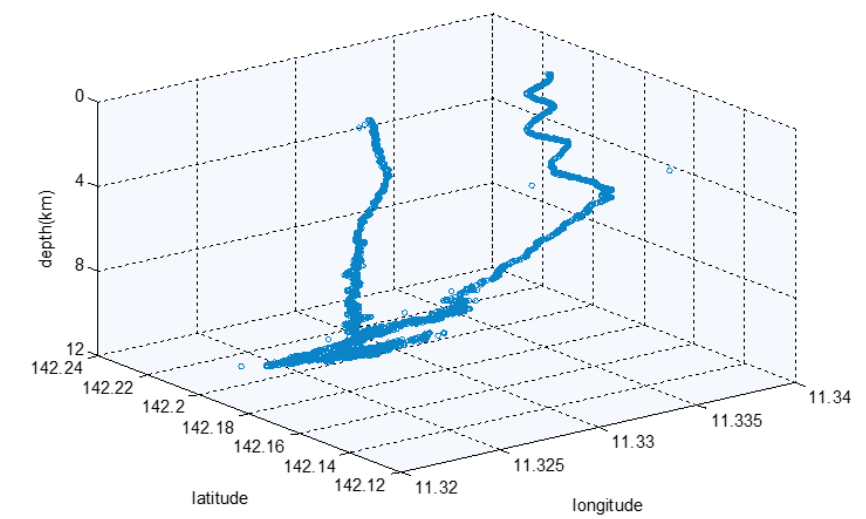
Figure 16. The USBL positioning track map.